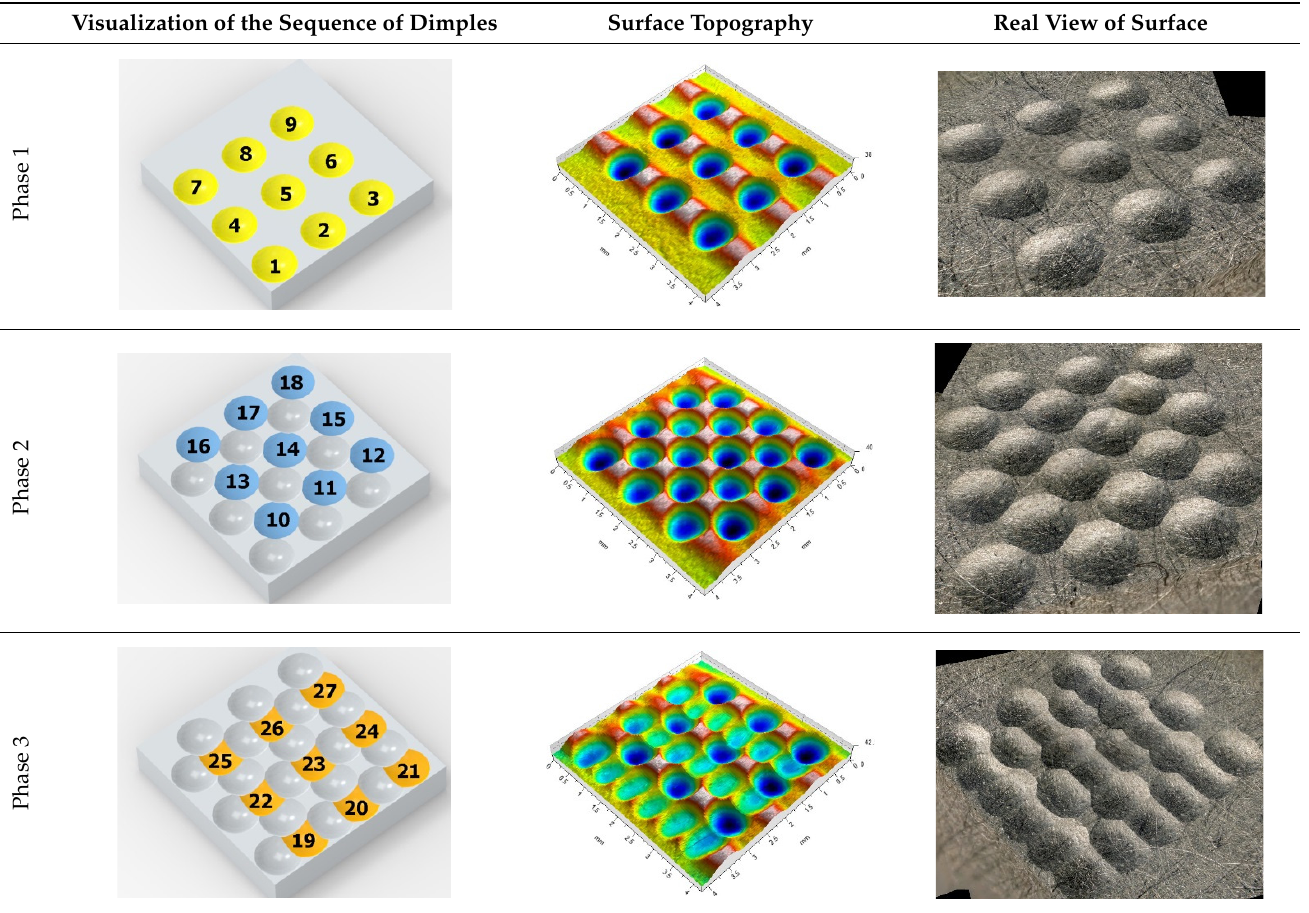
Materials 2021 , 14 , x FOR PEER